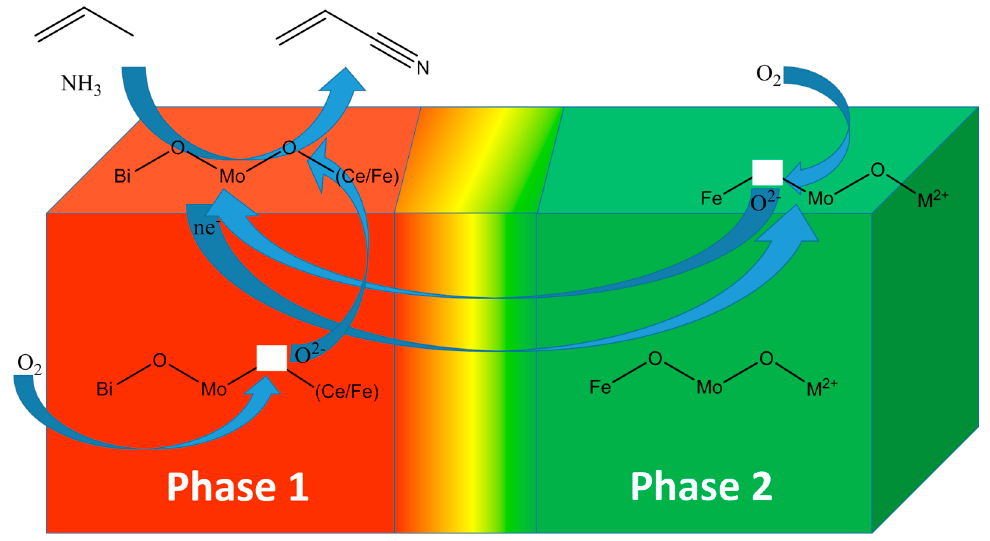
Figure 3. Schematic representation of multifunctionality in single and multiphase in an ammoxidation catalyst system.